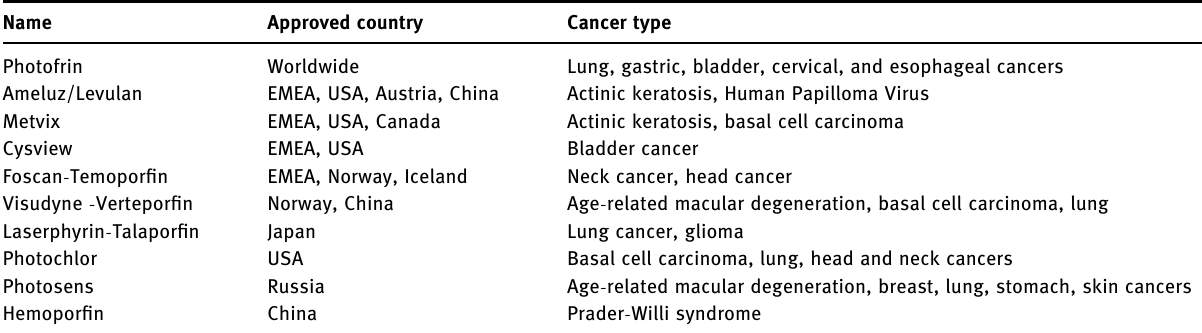
Table 1: Clinically approved photosensitizers [ 53